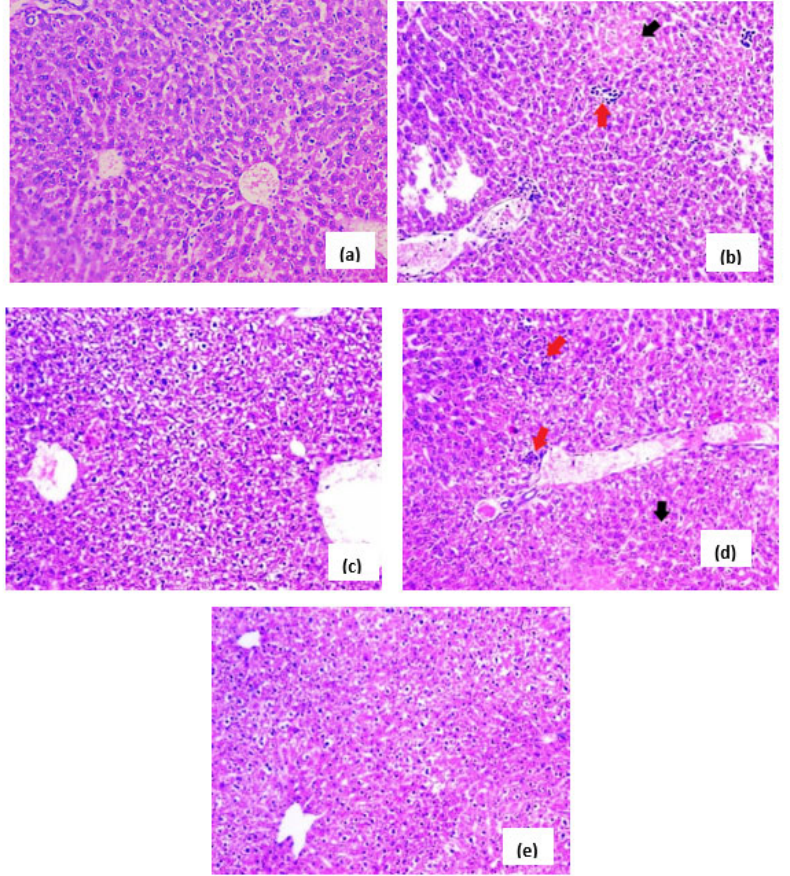
Figure 4. Histological photomicrographs of liver tissue (stained with H&E, unless mentioned otherwise, 200×). ( a ) Sections from normal mice (GI) showing a normal architecture of hepatic lobules. ( b ) Sections from infected mice (GII) displaying moderate degeneration of hepatocytes (black arrow) and focal infiltration with mononuclear cells (red arrow). ( c ) Sections from infected mice (GIII) treated with the reference drug, NTZ, displayed mild degeneration of hepatocytes. ( d ) Sections from infected mice (GIV) treated with H. hemistemon extract (100 mg/kg) showed moderate hepatocellular degeneration (black arrow) and focal infiltration by mononuclear cells (red arrow). ( e ) Sections from infected mice (GIV) treated with H. hemistemon extract (200 mg/kg) showed a retained hepatic lobular architecture. Table 4. Docking scores of the annotated compounds in H. hemistemon aerial-part extract inside